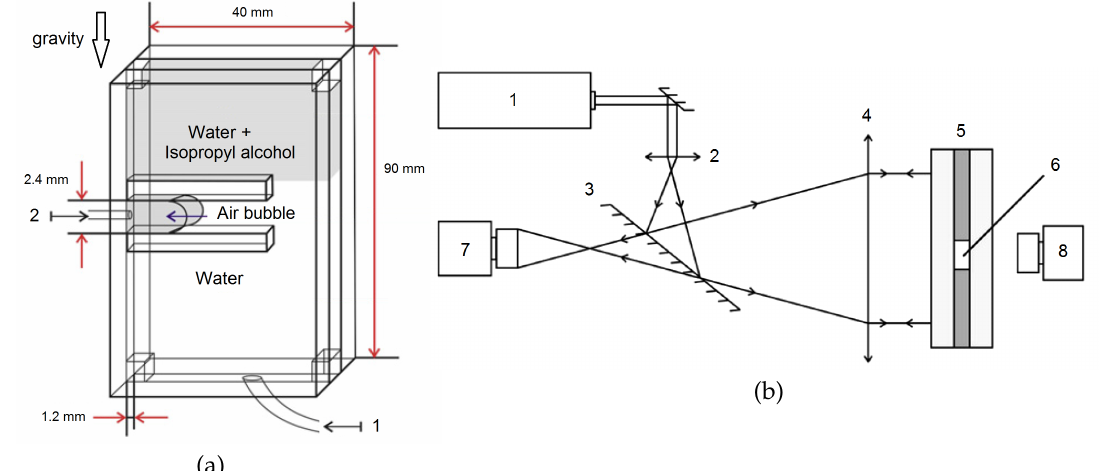
Figure 2. ( a ) Scheme of cuvette: the inlet for water during the filling procedure 1; the inlet for air to make the bubble 2. ( b ) Scheme of the Fizeau interferometer: helium-neon laser 1; microscope objective 2; semi-transparent mirror 3; objective-collimator 4; vertically oriented Hele–Shaw cell 5 with parallel glasses providing the workspace for interferometry; working chamber 6 with bubble or drop in channel; video cameras 7 and